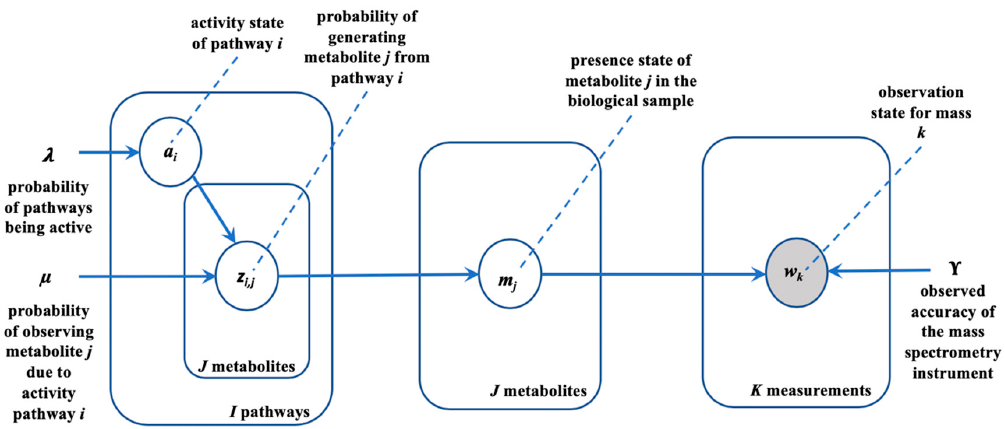
Figure 3. Graphical representation of the generative model. To avoid representing all I pathways, J metabolites, and K masses in the graph we use the ‘plate’ notation and draw one representative node per variable and enclosing these variables in a plate (rectangular box). The number of instances of each enclosed variable is indicated by the fixed constant in the lower right corner of the box. Random variables of the model ( a, z, m, w ) are shown in white circles. The variable m has a deterministic relationship with Z . The shaded circle, labelled w , represents an observed random variable. µ , λ , γ are parameters to the model.